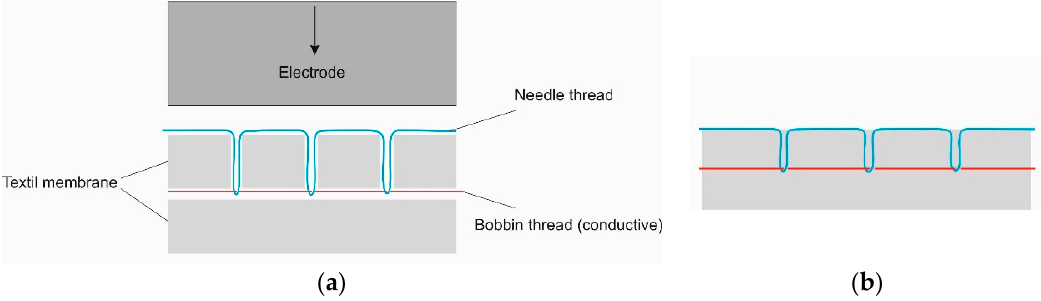
Figure 9. Graphical illustration of ( a ) HF welding with a conductive sewing thread and ( b ) a finished HF welded seam with integrated sensor.